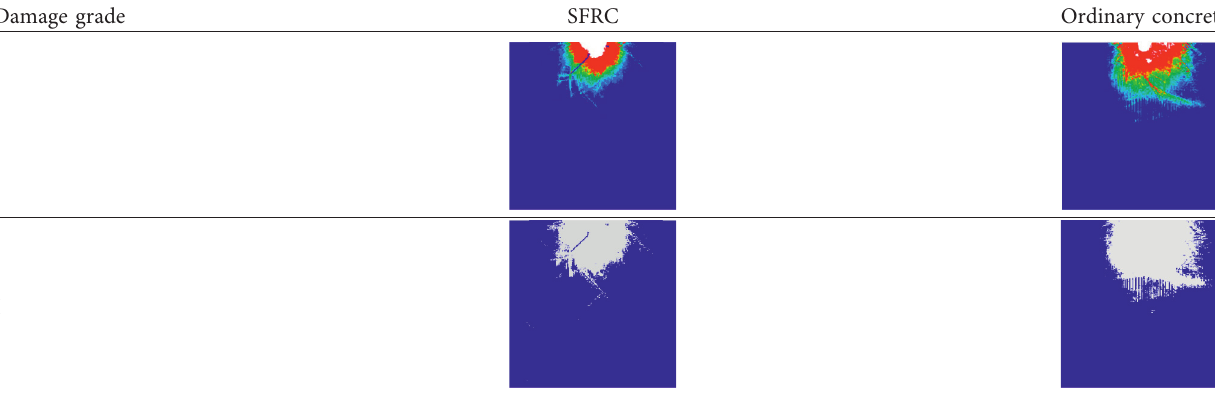
Table 4: Color gamut comparison of SFRC and the ordinary concrete with different damage